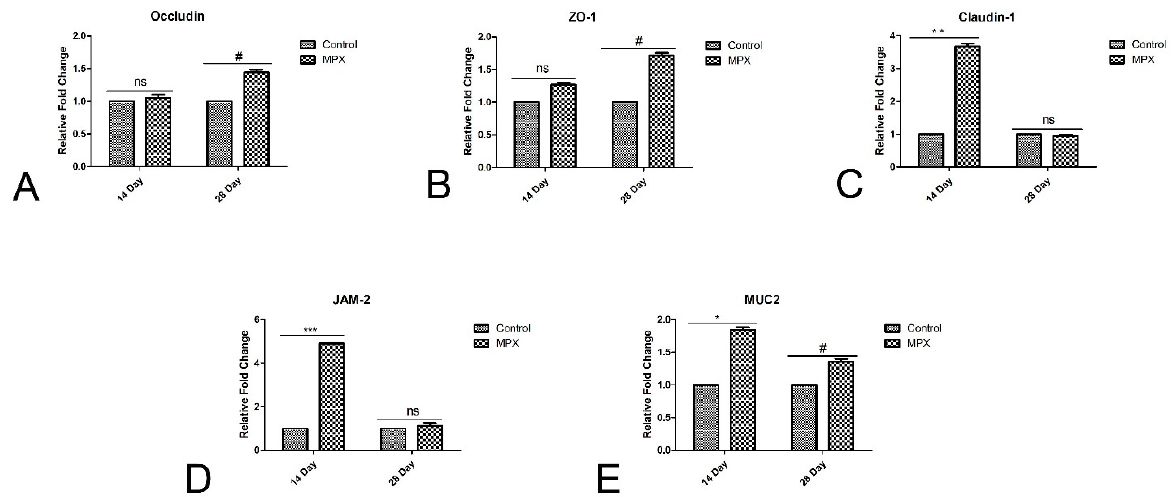
Figure 4. Effects of MPX supplementation on tight junction proteins in broiler chickens at 14 d and 28 d. ( A ) mRNA expression of Occludin in chickens at 14 d and 28 d. ( B ) mRNA expression of ZO-1 in chickens at 14 d and 28 d. ( C ) mRNA expression of Claudin-1 in chickens at 14 d and 28 d. ( D ) mRNA expression of JAM-2 in chickens at 14 d and 28 d. ( E ) mRNA expression of MUC2 in chickens at 14 d and 28 d. ns represents no significant difference between control group and MPX group; # represents significant difference between control group and MPX group at 28 d, p < 0.05; * represents significant difference between control group and MPX group at 14 d, p < 0.05; ** represents significant difference between control group and MPX group at 14 d, p < 0.01; *** represents significant difference between control group and MPX group at 14 d, p < 0.001.